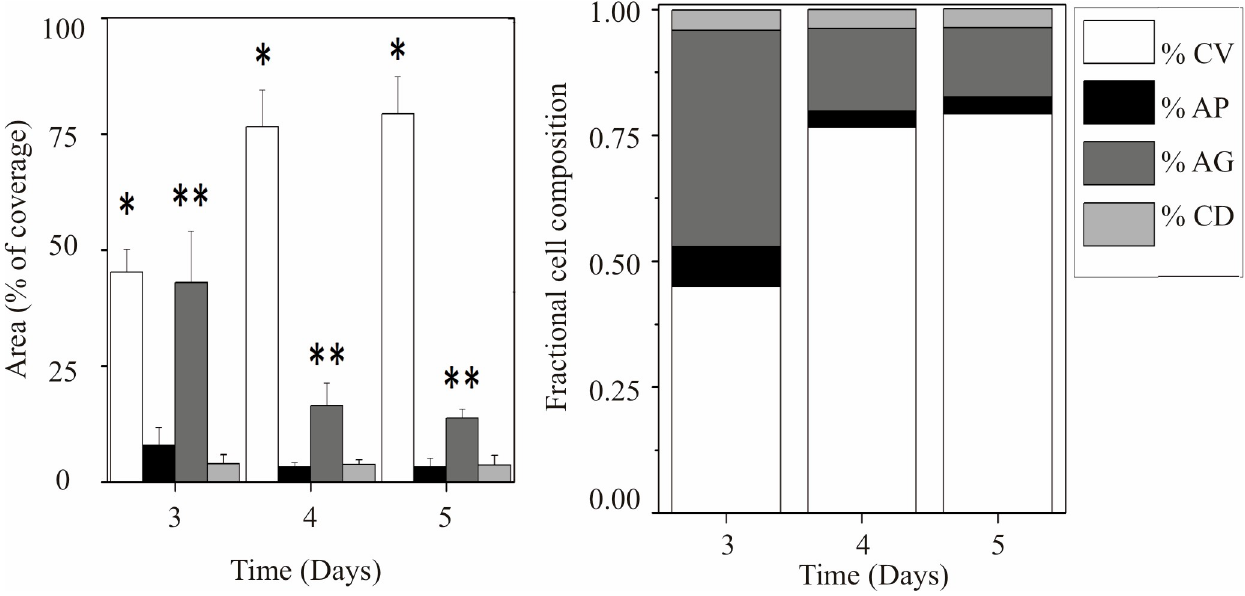
Fig 3. Cell distribution after characterization with stainings for 5 days. Right, stacked bar graph illustrating cell fraction composition per day over the five-day period. Left, the surface area covered by live cells (CV) increased while the levels of the autophagy process decreased (AG) significantly. ( � ) and ( �� ) indicate significant difference between days among the subgroups (p <